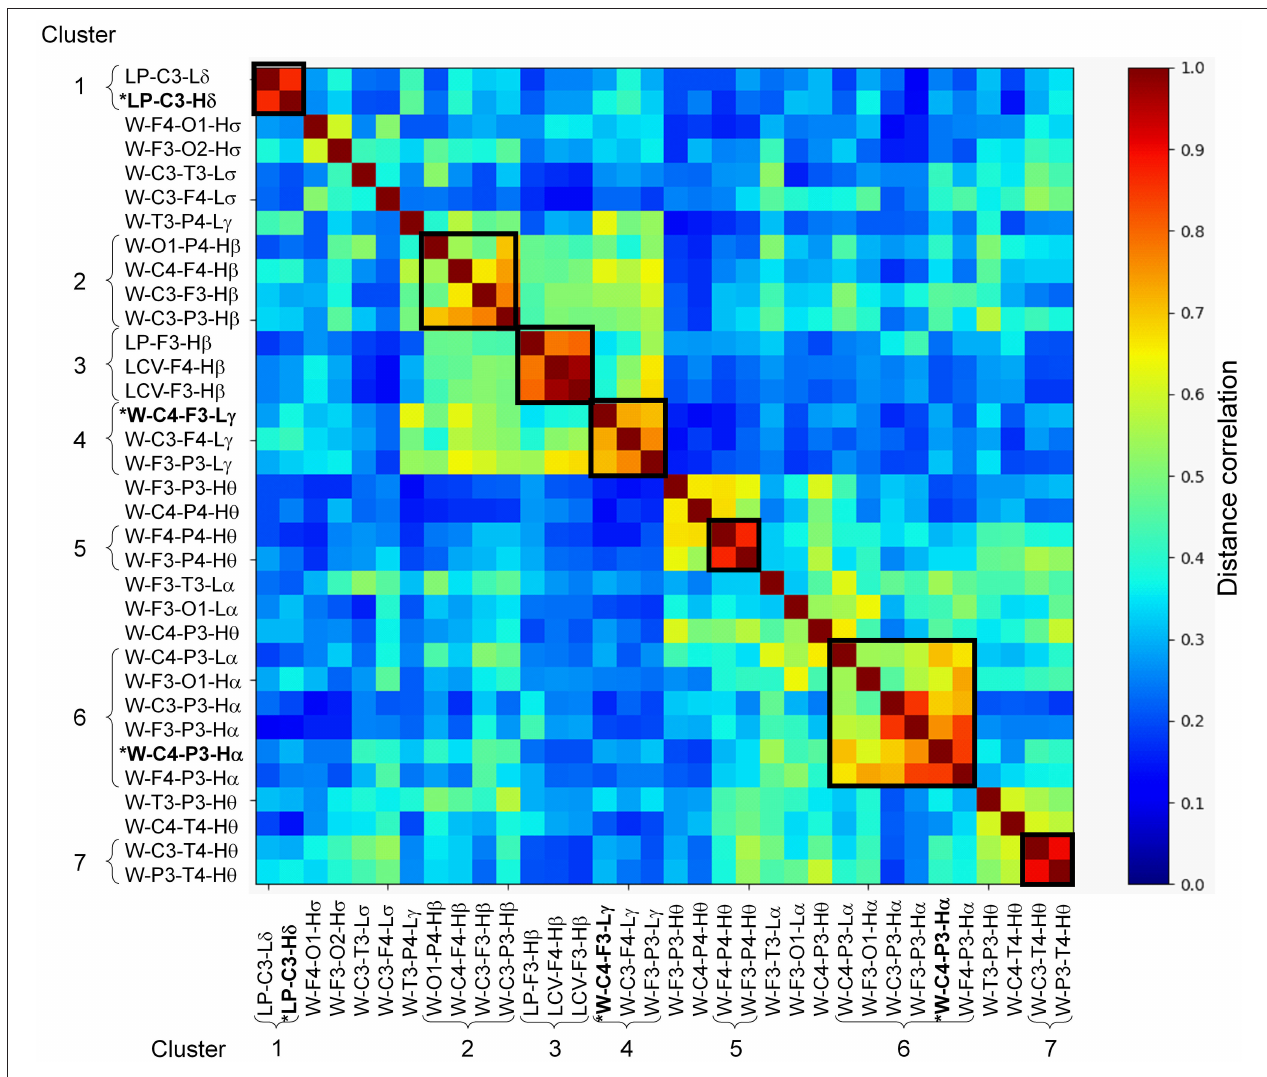
FIGURE 3 | Distance correlation between the 34 stage-independent, whole-night features extracted from 10 electroencephalography channels across both nights of the training set (those obtained after step 4 in Figure 2 ). Dendrogram clustering revealed seven clusters with correlation values exceeding 0.7 (dark squares in the image, where the curly brackets identify the features within a cluster). Features marked with asterisk and highlighted in bold-face text (one each in clusters 1, 4, and 6) indicate the three features selected via recursive feature elimination. The 12 independent features obtained after step 5 in Figure 2 are located between the seven